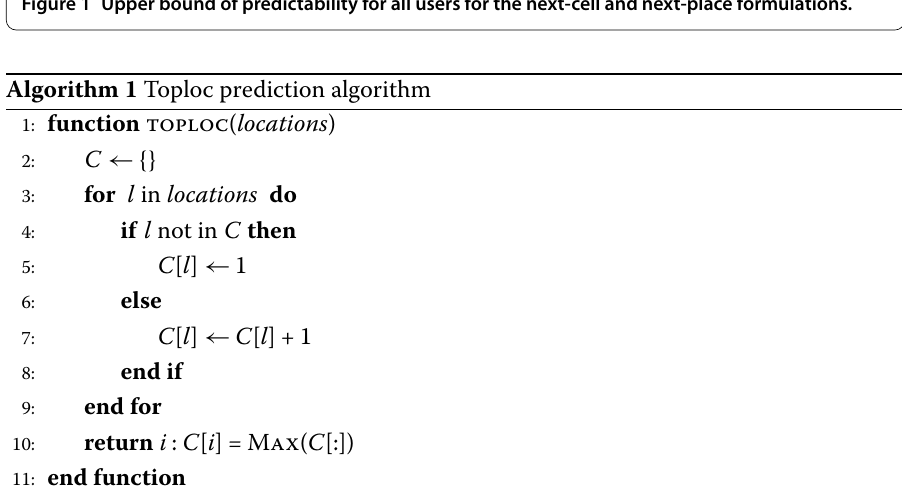
Figure 1 Upper bound of predictability for all users for the next-cell and next-place formulations.